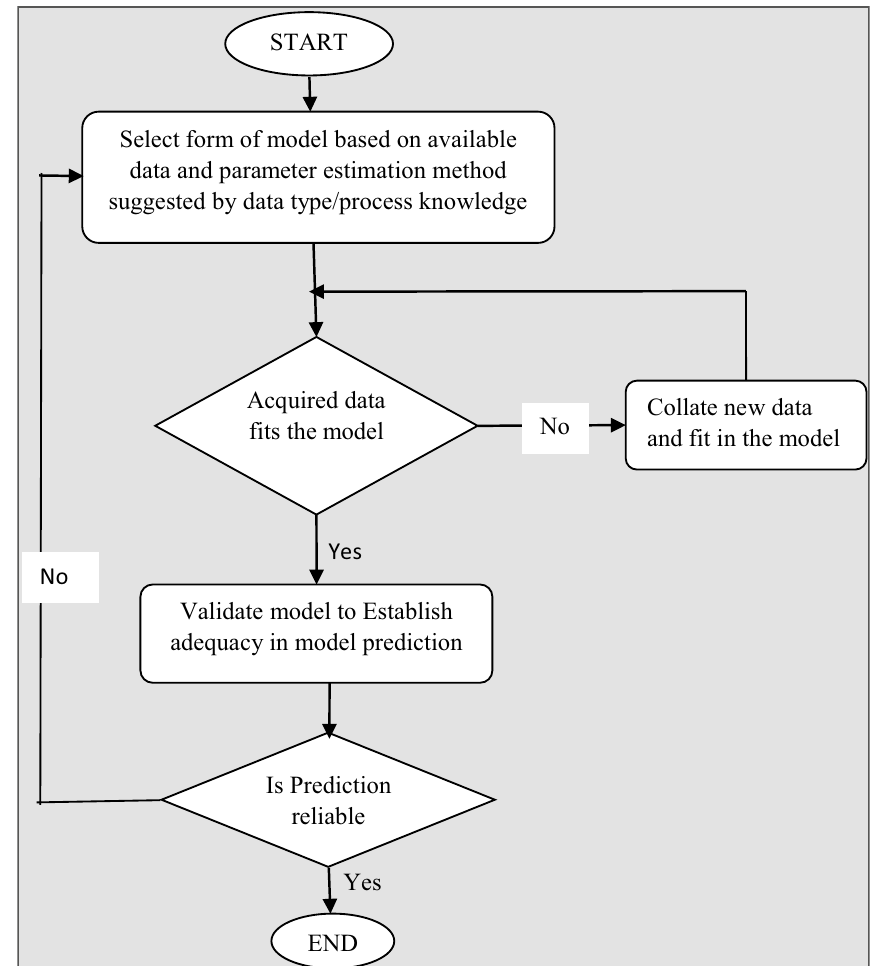
Fig. 1 Flow diagram showing the steps required in building a species distribution